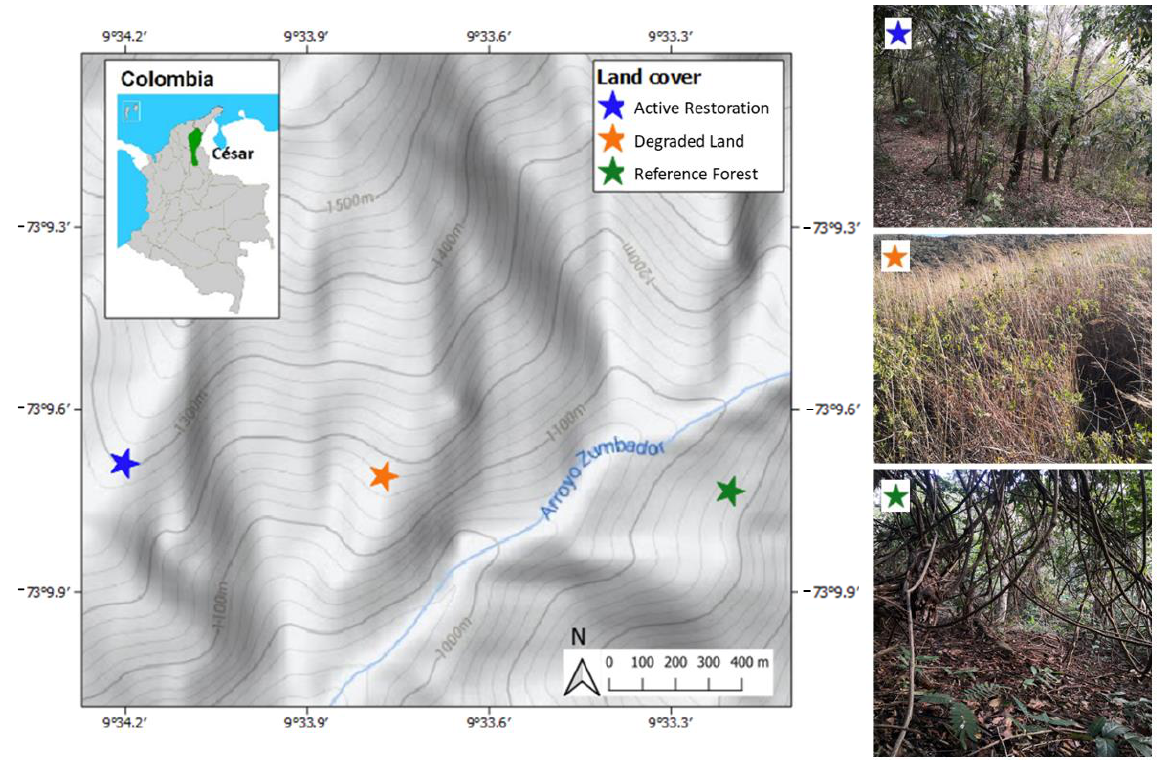
Figure 1. Map of the study area within the Department of Cesar, Colombia, and pictures showing the characteristic vegetation cover of each